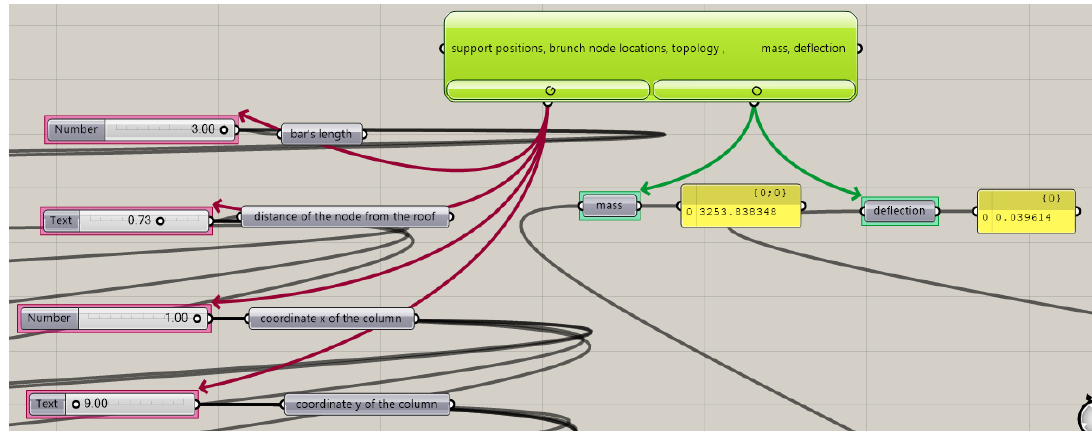
Figure A3. Result of the simulation for a structure with pattern a